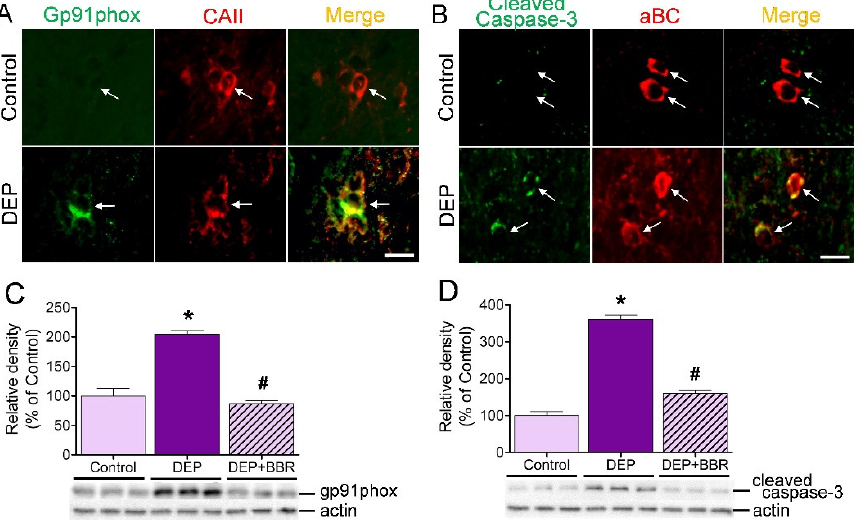
Figure 7. Expressions of gp91phox (NOX2) and cleaved caspase-3 in the cerebellum of mice exposed to ultrafine DEPs for 1 week. ( A , B ) Double immunofluorescence staining. Unlike the control, the CAII-positive and aBC-positive oligodendrocytes overlapped with the gp91phox ( A ) and cleaved caspase-3 ( B ) are found in the cerebellar white matter of the mouse brain exposed to ultrafine DEPs. ( C , D ) Quantitative analysis. The expressions of gp91phox ( C ) and cleaved caspase-3 ( D ) in the mouse cerebellum exposed to ultrafine DEPs are significantly higher than those in each control group. However, BBR treatment significantly suppressed the expressions of gp91phox and cleaved caspase-3 in the cerebellum exposed to ultrafine DEPs. * p < 0.05 for DEP group vs. control, # p < 0.05